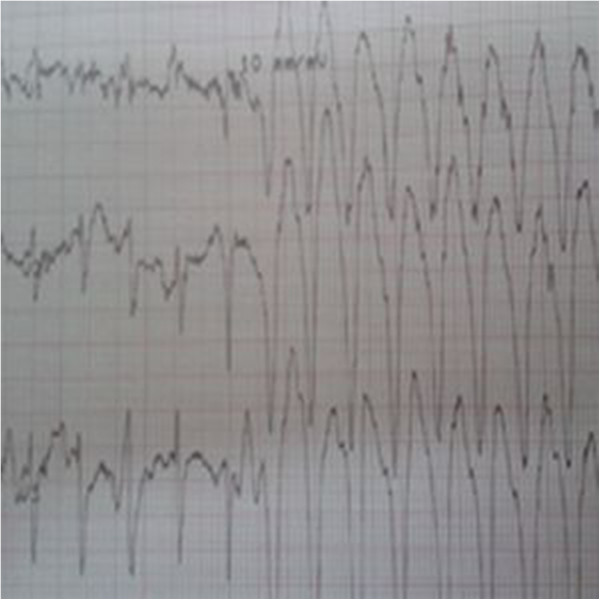
Electrocardiogram showing a run of ventricular tachycardia.